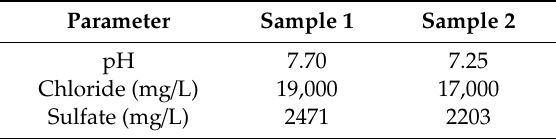
Figure 5. Loading test arrangement. Figure 6. Loading test of geopolymer concrete beam (GCB). 3. Results and Discussion 3.1. Compressive and Splitting Tensile Strength of Concrete Cylinders